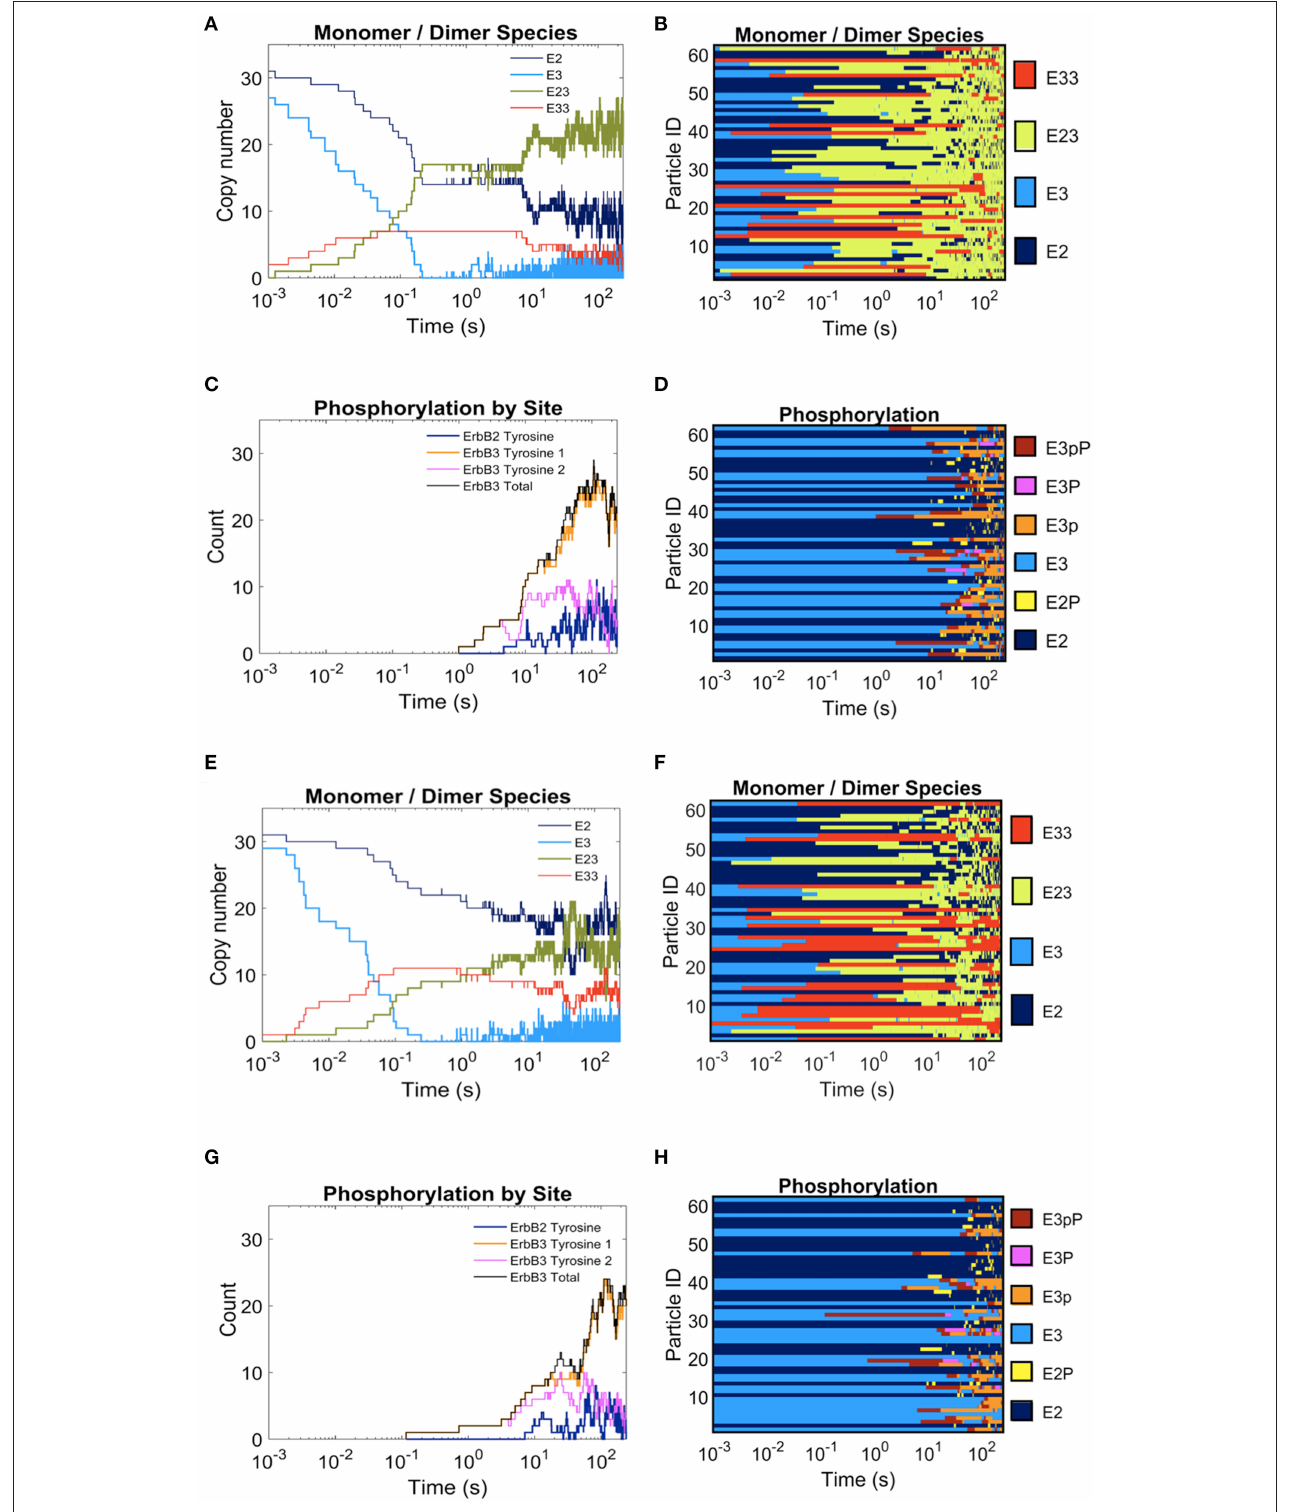
FIGURE 3 | The effect of overlapping domains on ErbB2/ErbB3 dimerization and phosphorylation kinetics with 100% ligand-bound ErbB3. Plots for the completely overlapping domain configuration (A–D) : The kinetics of dimer formation (A) , representative plots of dimerization state for individual receptors over the simulation time (B) , the kinetics of receptor phosphorylation (C) , and a representative plot of phosphorylation state for receptors over time (D) . (E–H) : Plots for the non-overlapping domain configuration. Plots are arrayed as in (A–D) .